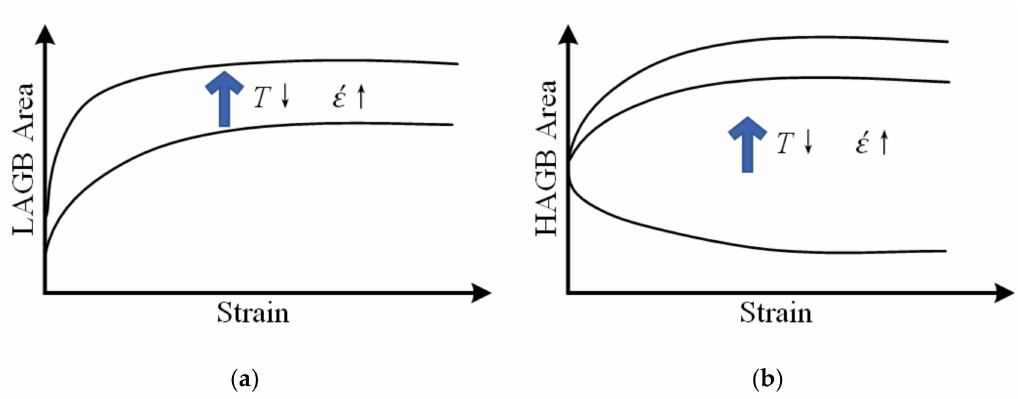
Figure 8. Schematic illustration of changes in boundary area with strain: ( a ) LAGB area evolution and ( b ) HAGB area evolution per unit volume, which have similar trends but di ff erent mechanisms depending on whether or not recrystallisation occurs.